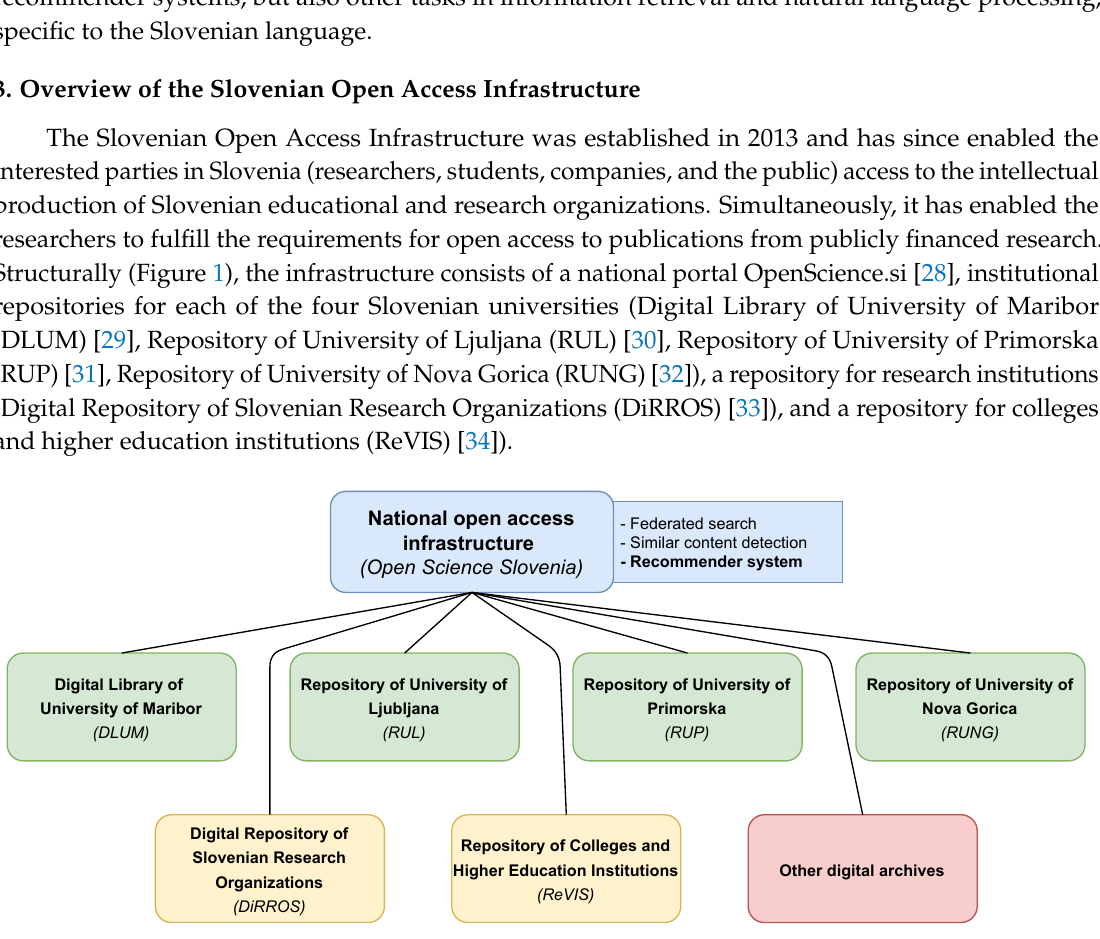
Figure 1. Structure of the Slovenian Open-Access